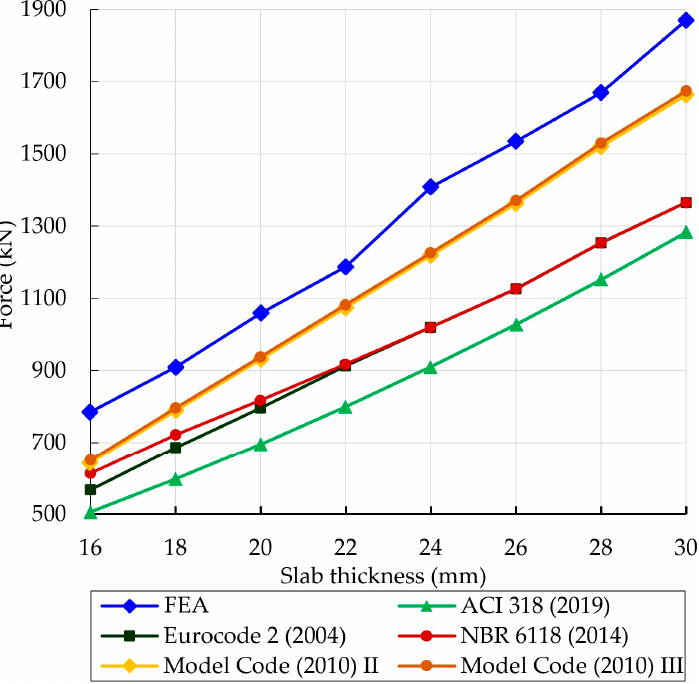
Figure 19. Failure load evolution in relation to the spacing of prestressing tendons (Series T) [11–14].